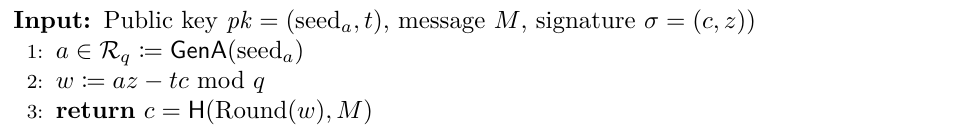
Algorithm 9 qTESLA Verify (simplified)